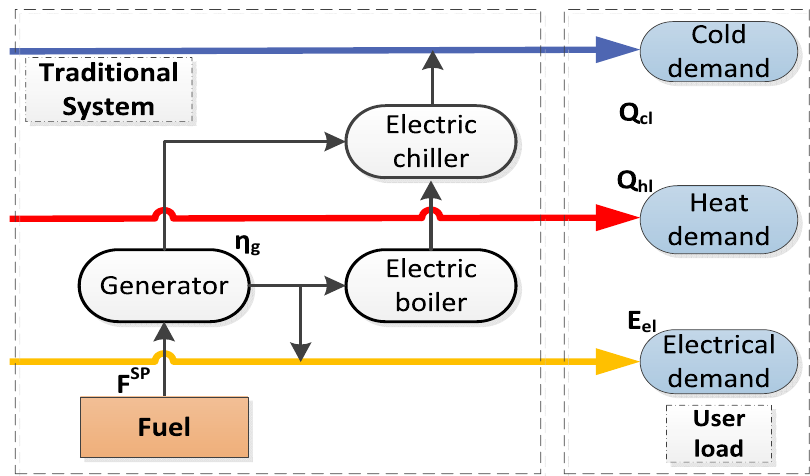
Figure 1. Illustration of the traditional energy system structure in isolated